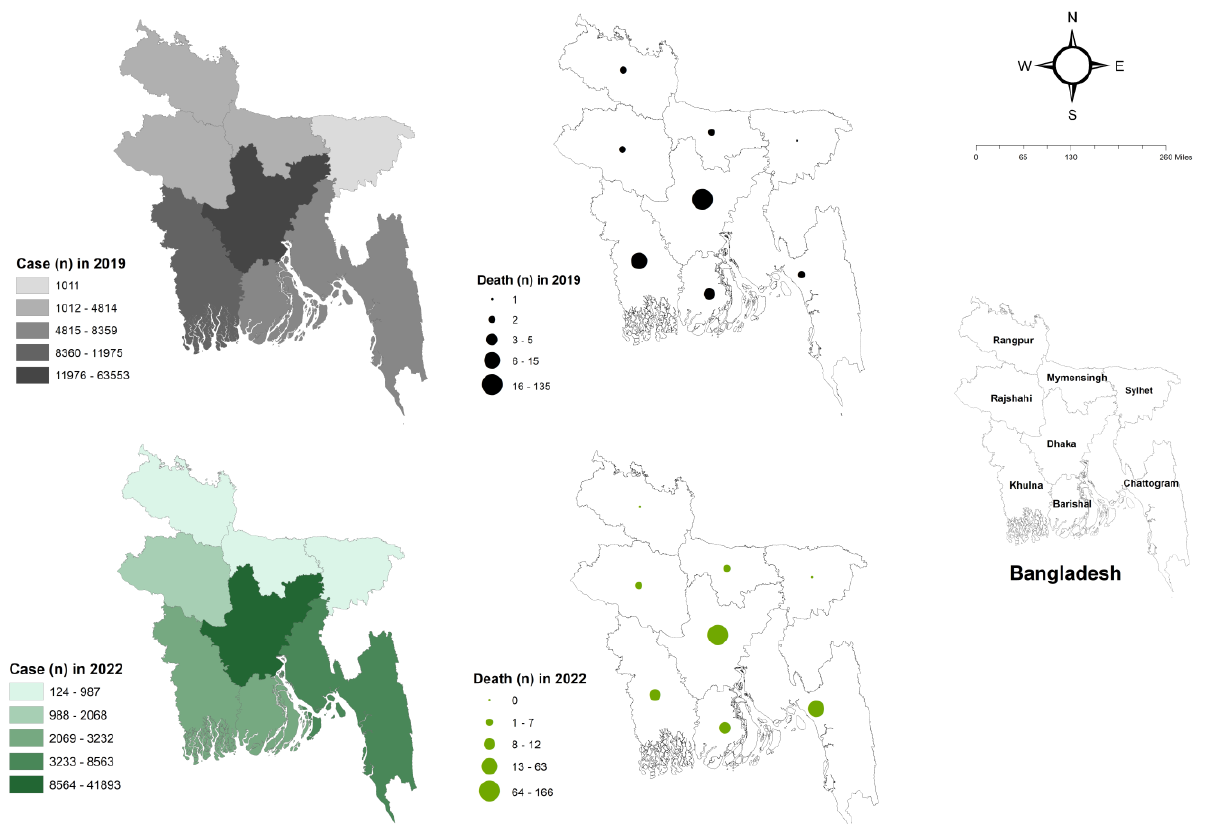
Figure 2. Dengue case and dengue-related death reported in 2019 and 2022 in different divisions of Bangladesh. The number of dengue case and dengue-related death in the years 2019 and 2022 (as on 10 December 2022) in different divisions (Dhaka, Chattogram, Rajshahi, Khulna, Sylhet, Barishal, Rangpur, and Mymensingh) of Bangladesh are shown. ArcGIS-ArcMap version 10.2 (ESRI, Redlands, CA, USA) was used to produce a choropleth map of the frequency of dengue cases and a graduated symbol map of the number of deaths in different divisions (Dhaka, Chattogram, Rajshahi, Khulna, Sylhet, Barishal, Rangpur, and Mymensingh) of Bangladesh.